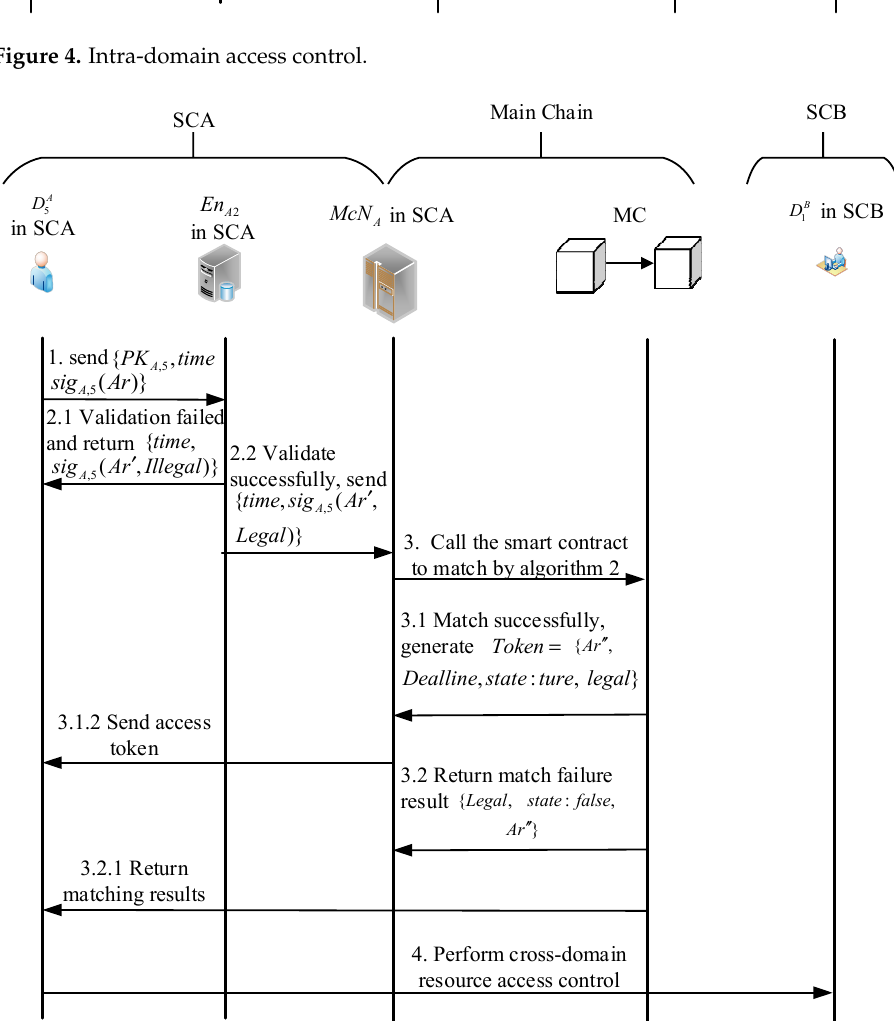
Figure 5. Cross-domain access control process.